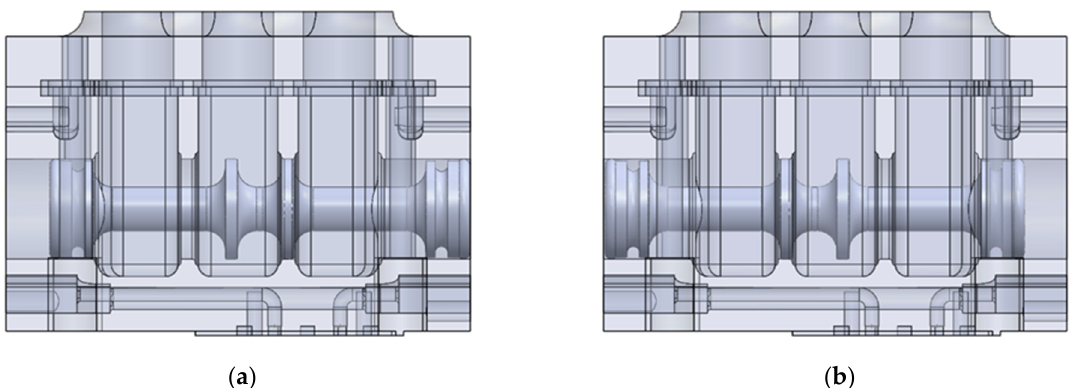
Figure 1. Diagram of the 3/2 valve ( a ) fluid flowing along ways 1 and 2, with way 3 being cut off ( b ) fluid flowing along ways 2 and 3, with way 1 being cut off.